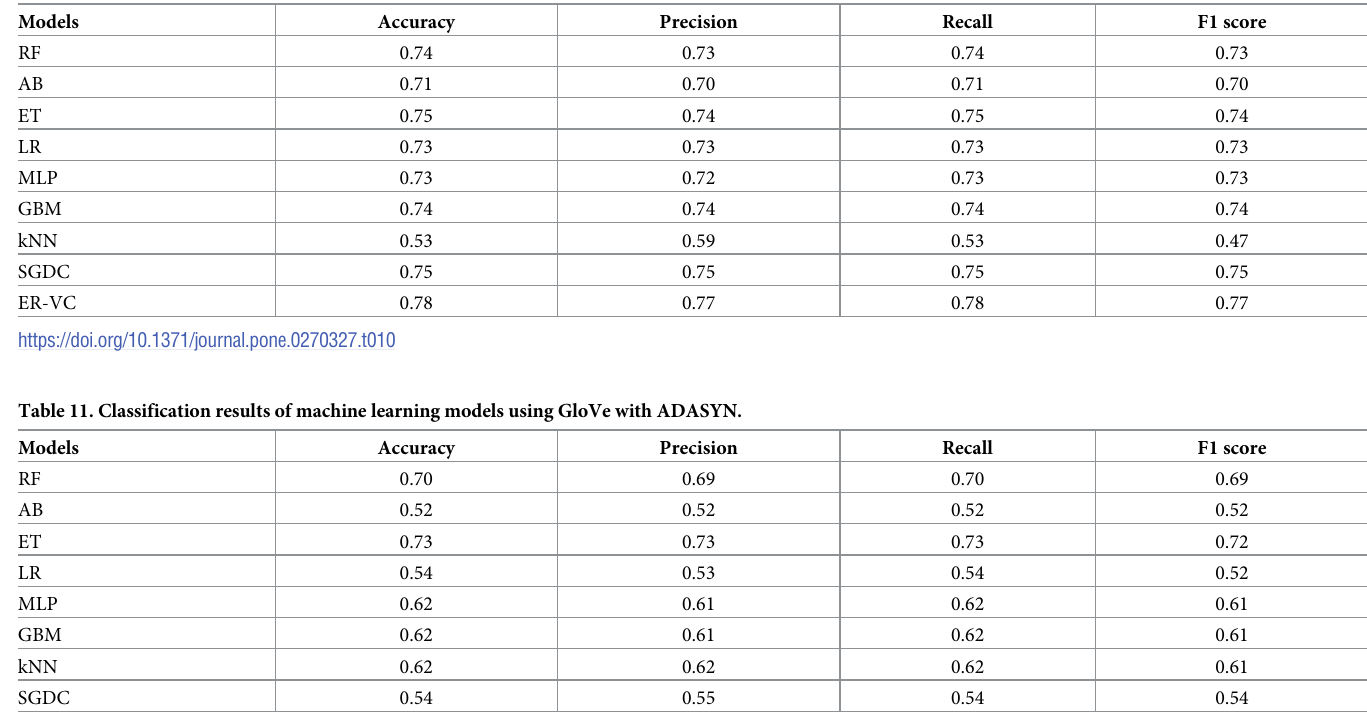
results with ADASYN-balanced dataset than SMOTE-based dataset when trained on BoW fea- tures. The performance of the ML models including the proposed ER-VC is degraded with ADASYN on BoW features. Lastly, ML models are trained on GloVe features using ADASYN to predict adverse reac- tions. Results in Table 11 present that ML models show lower performance with ADASYN than SMOTE. Results reveal that using BoW and GloVe with ADASYN does not provide bet- ter accuracy as compared to BoW and GLoVe with SMOTE. ADASYN shows the best results using the TF-IDF technique.